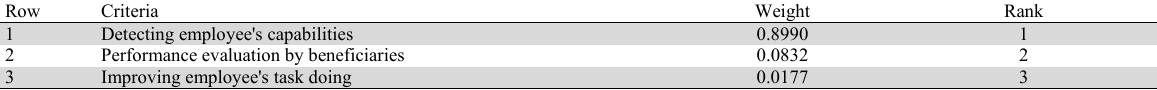
Ranking of performance evaluation sub-criteria